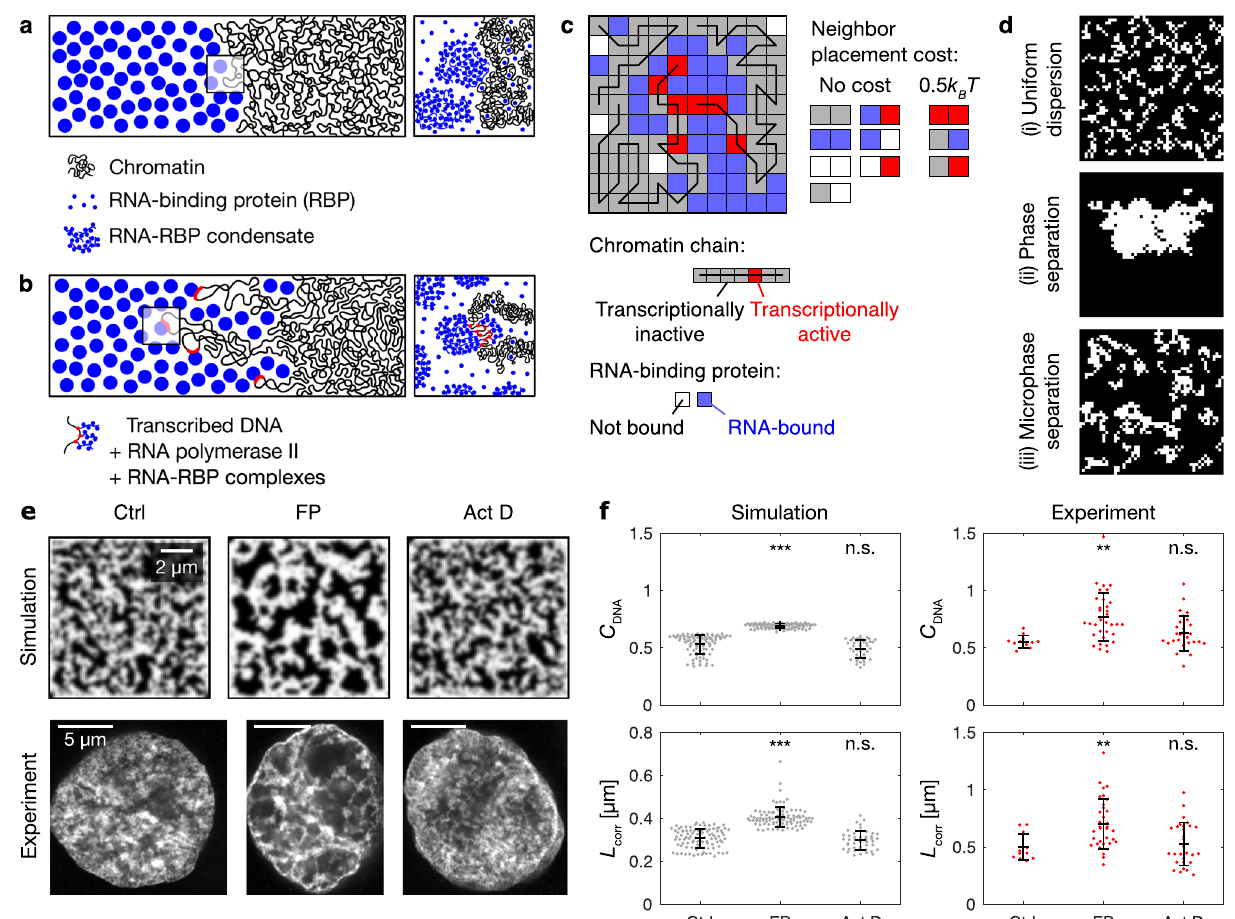
Fig. 3 A microemulsion model reproduces key features of euchromatin organization. a Model mechanism 1: segregation of RNA-RBP condensates from chromatin. b Model mechanism 2: tethering of RNA-RBP complexes to transcriptionally active chromatin, forming amphiphilic connections. c Illustration of the lattice model for euchromatin organization, indicating chromatin chains and RNA-binding proteins with different states, as well as the costs for placing different types of lattice sites next to each other. See Supplementary Table 1 for model parameters. d Con fi gurations of chromatin (white) in long-term simulations of the lattice model with (i) no RNA and no transcription, (ii) RNA and no transcription, and (iii) RNA and transcription. e Concentration pro fi les from simulations with example STED nuclear mid-sections from corresponding experimental conditions: control treatment (Ctrl), fl avopiridol (FP), actinomycin D (Act D). The same results were obtained in four independent experiments. f Comparison of DNA image contrast ( C DNA ) and correlation length ( L corr ) from simulations and STED mid-nuclear sections. Mean ± SD, ** indicates P < 0.01, *** indicates P < 0.001, n.s. indicates P ≥ 0.05 ( C DNA P values <10 − 5 , 0,33 from a two-sided permutation test, L P values 0.003, 1.09 from a two-sided permutation test, P values with Bonferroni correction corr for multiple testing and resampling n matched to experiments, n = 96,93,46 simulations, for a description of the statistics of experiments, see Fig.